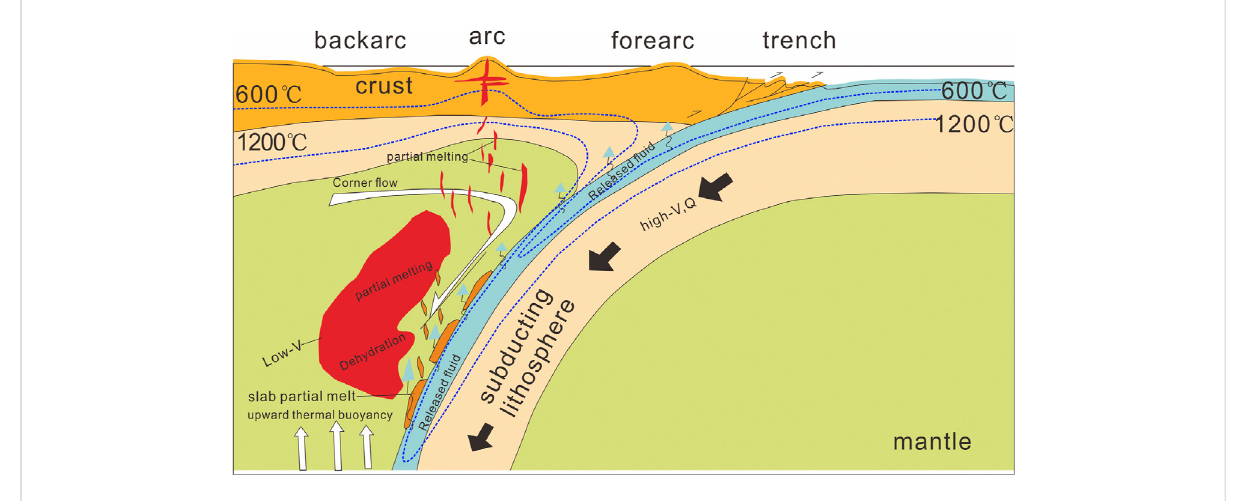
FIGURE 12 SchematicstructuremodelofJapansubductionzonebuiltonthecalculated seismicvelocitystructures.Temperaturecontours arereferenced from (Wada et al.,